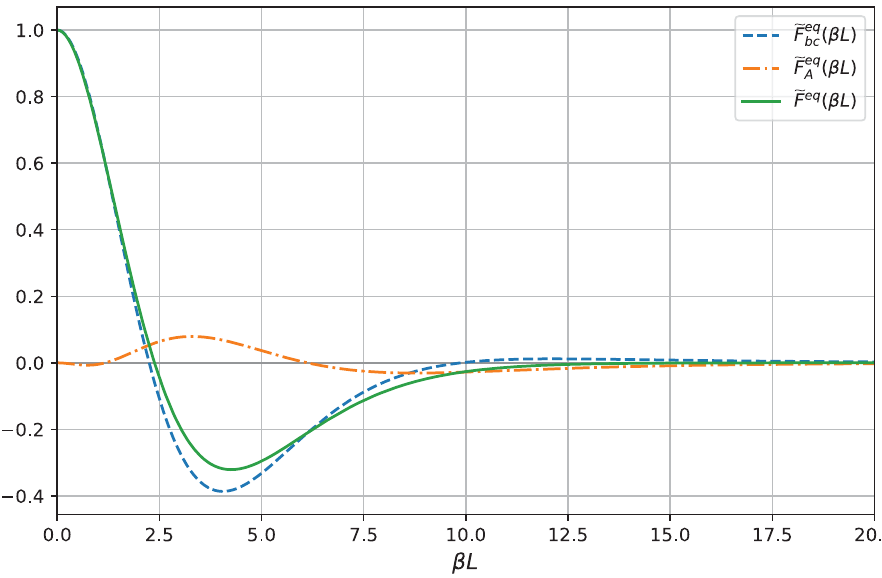
Figure 2. The Casimir force, in the case that the chiral medium is only present between the plates, relative to the QED Casimir force originating from the boundary conditions of the chiral medium in Figure